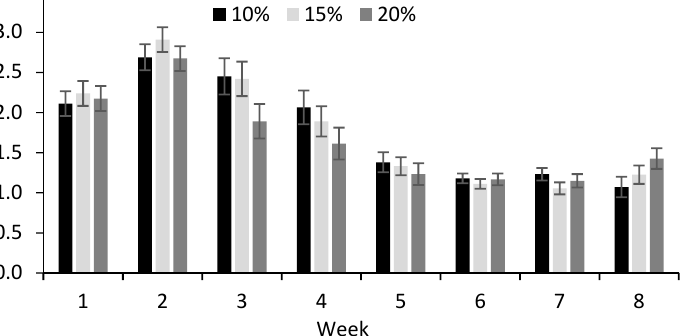
Figure 4. Average weekly fecal score of preweaning dairy calves previously fed different volumes of colostrum. 10% BW as colostrum (n = 10); 15% BW as colostrum (n = 10); 20% BW as colostrum (n = 10). Possible scores were (0) for firm feces, no diarrhea; (1) for soft feces, no diarrhea; (2) for mild diarrhea; and (3) for watery, severe diarrhea. Time effect ( p < 0.001).